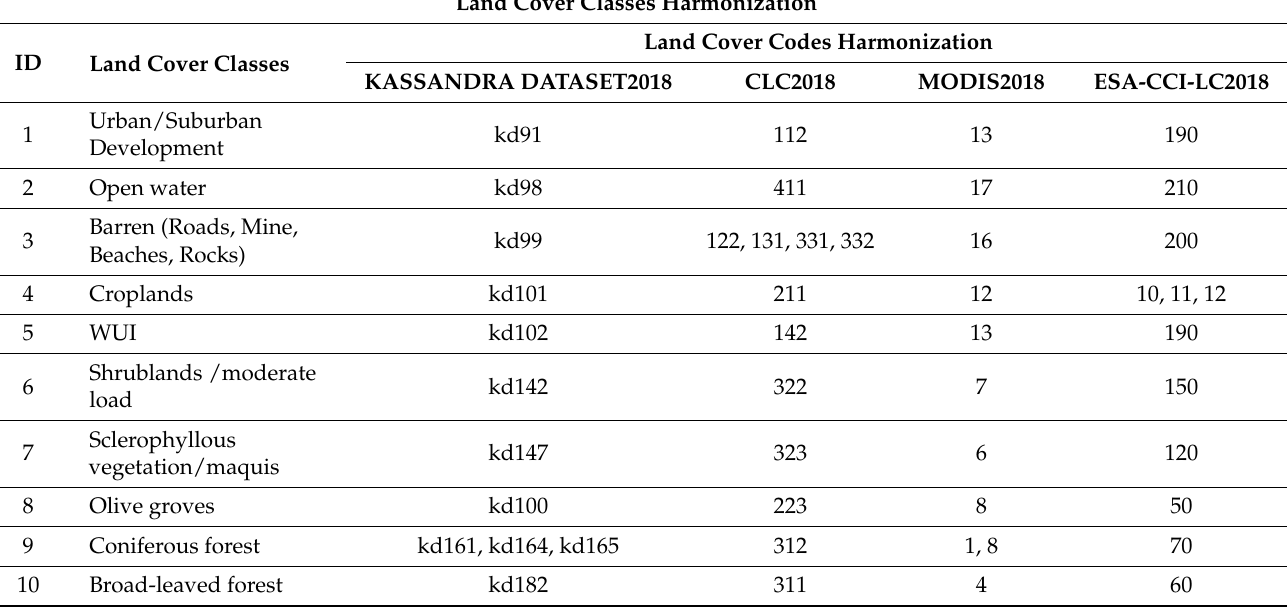
Table 3. Kassandra land cover classes harmonization with the respective class codes of the other three used